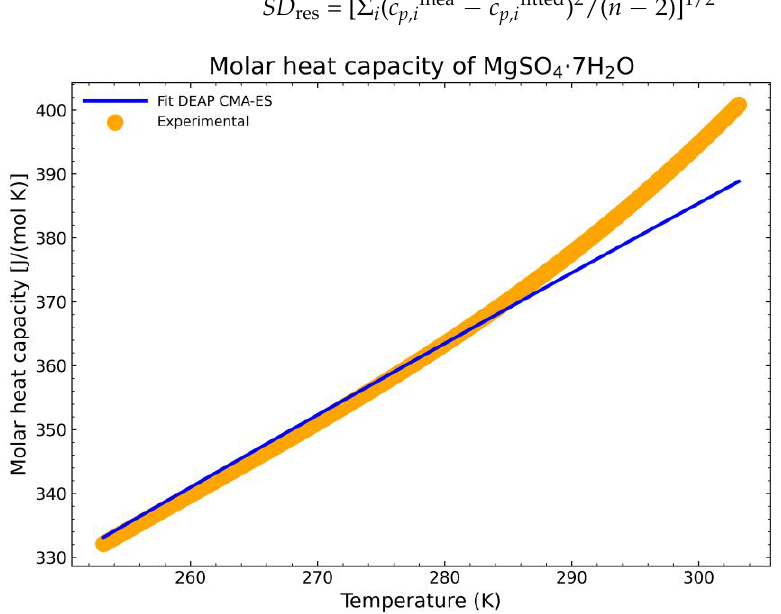
Figure 18. Comparison between the fitted heat capacity with the CMA-ES method and the experi- mental output from the DSC setup.